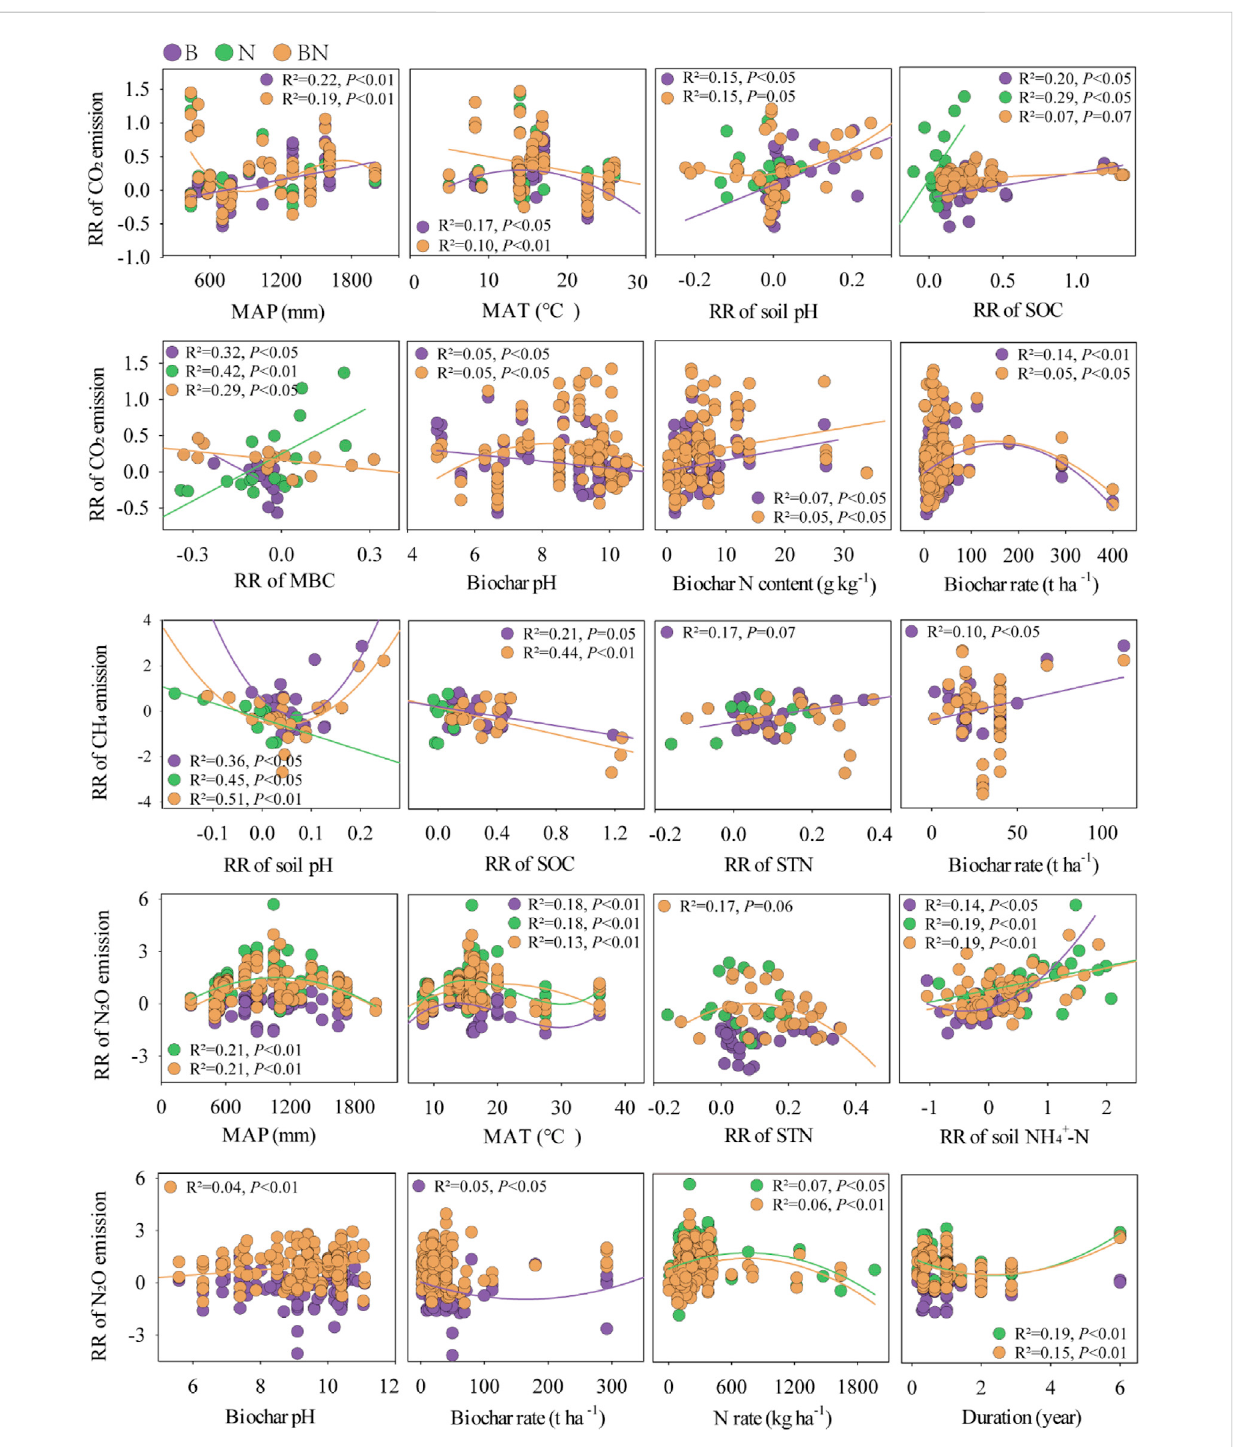
FIGURE 4 Relationships between the predictors and the responses of soil GHGs. MAP, mean annual precipitation; MAT, mean annual